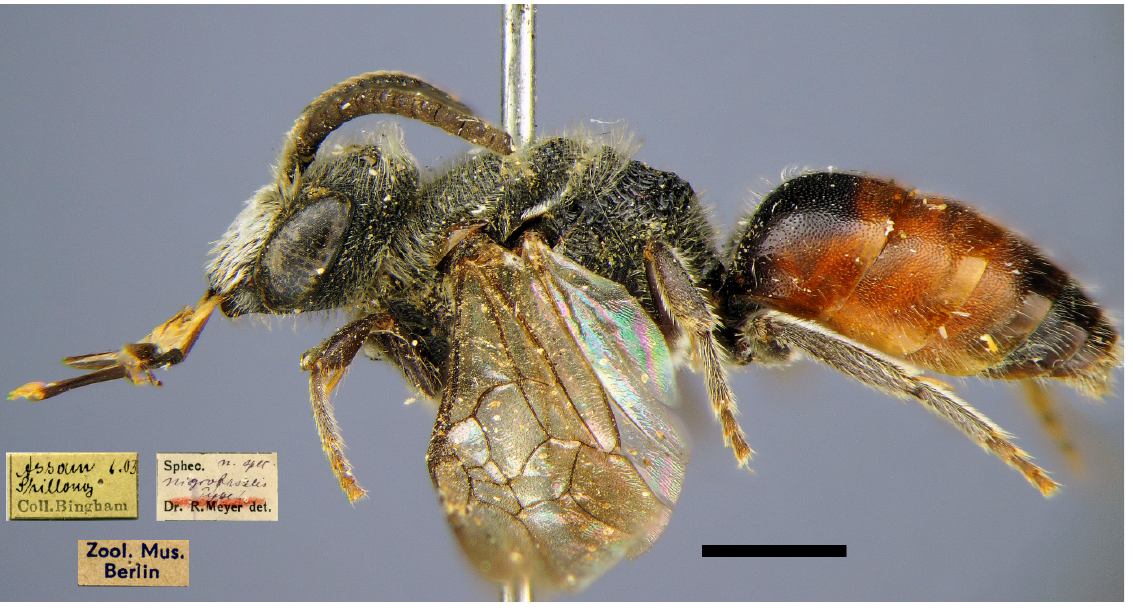
Fig. 9. Sphecodes invidus (Cameron, 1897) (holotype of S. nigrobasalis Meyer, 1922), ♂ (ZMHB). Habitus in lateral view and labels. Scale bar = 1